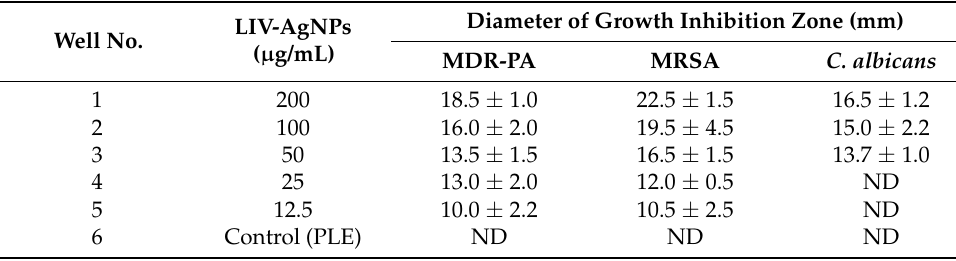
Table 1. Determination of zone of inhibition (in mm) values of LIV-AgNPs.